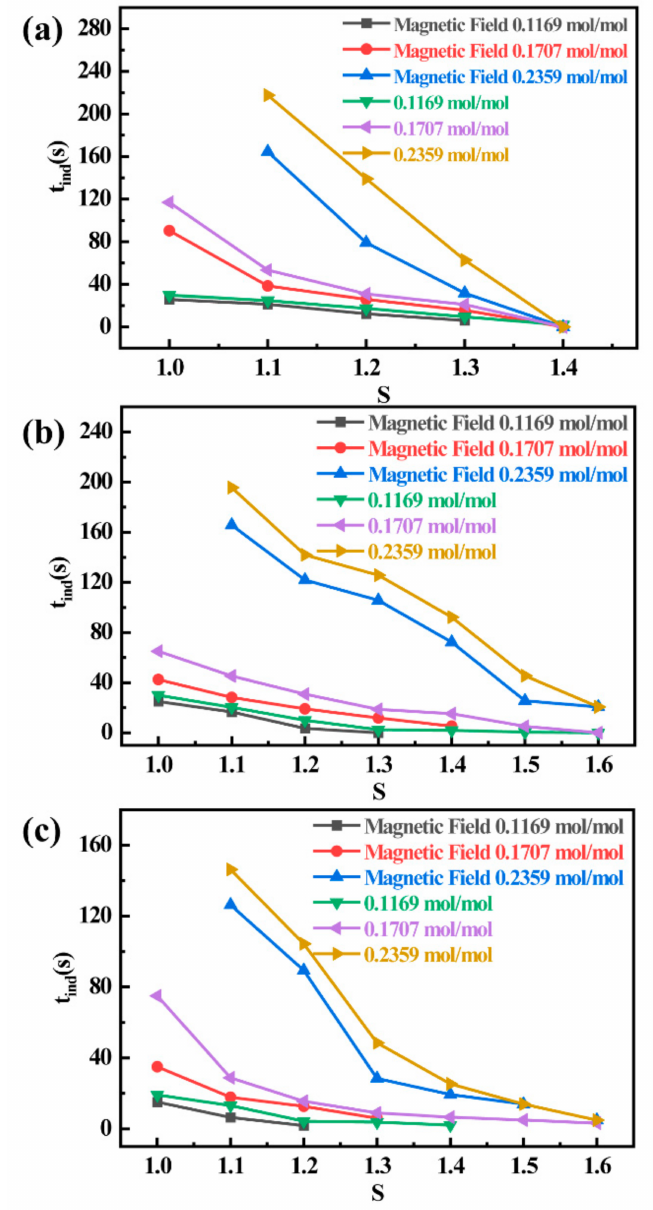
Figure 4. ( a ) Variation of induction period with supersaturation in the presence and absence of a magnetic field ( t = 15 ◦ C). ( b ) Variation of induction period with supersaturation in the presence and absence of a magnetic field ( t = 20 ◦ C). ( c ) Variation of induction period with supersaturation in the presence and absence of a magnetic field ( t = 25 ◦